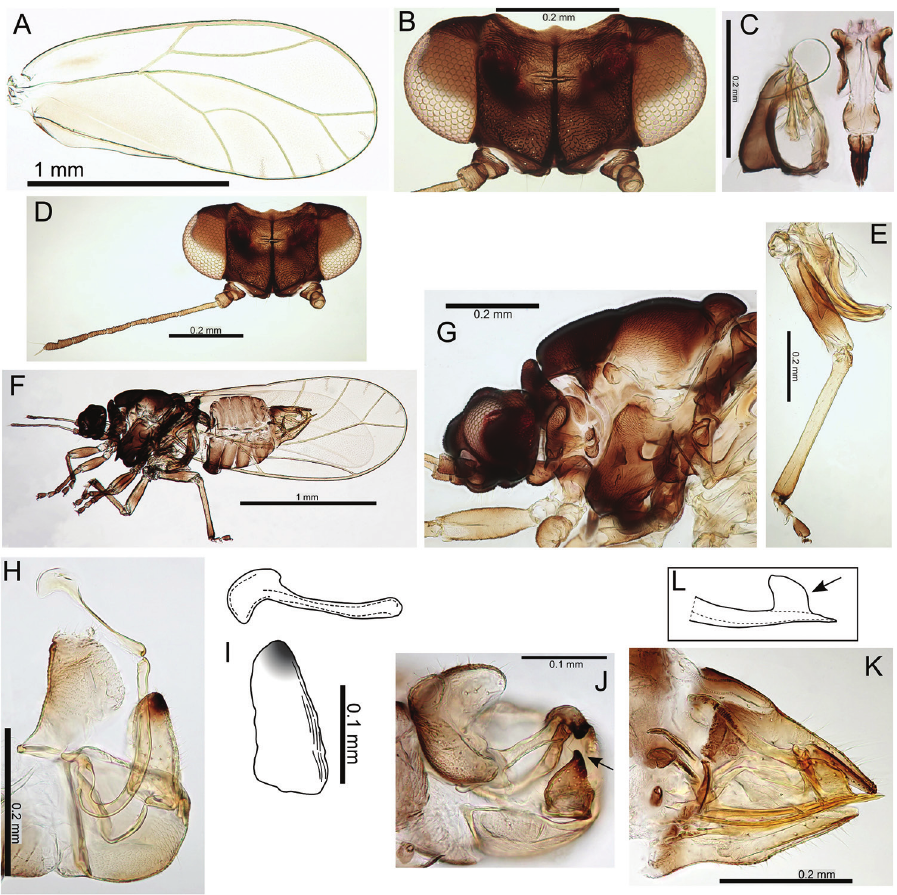
Figure 20. Pariaconus gibbosus sp. n. A fore wing B head C proboscis D head and antenna E hind leg F female G head and thorax H male terminalia I aedeagus and paramere J male terminalia (dorsal view, in- ward directed apex indicated) K female terminalia L ovipositor (convex shape of valvulae dorsalis indicated). kamua species